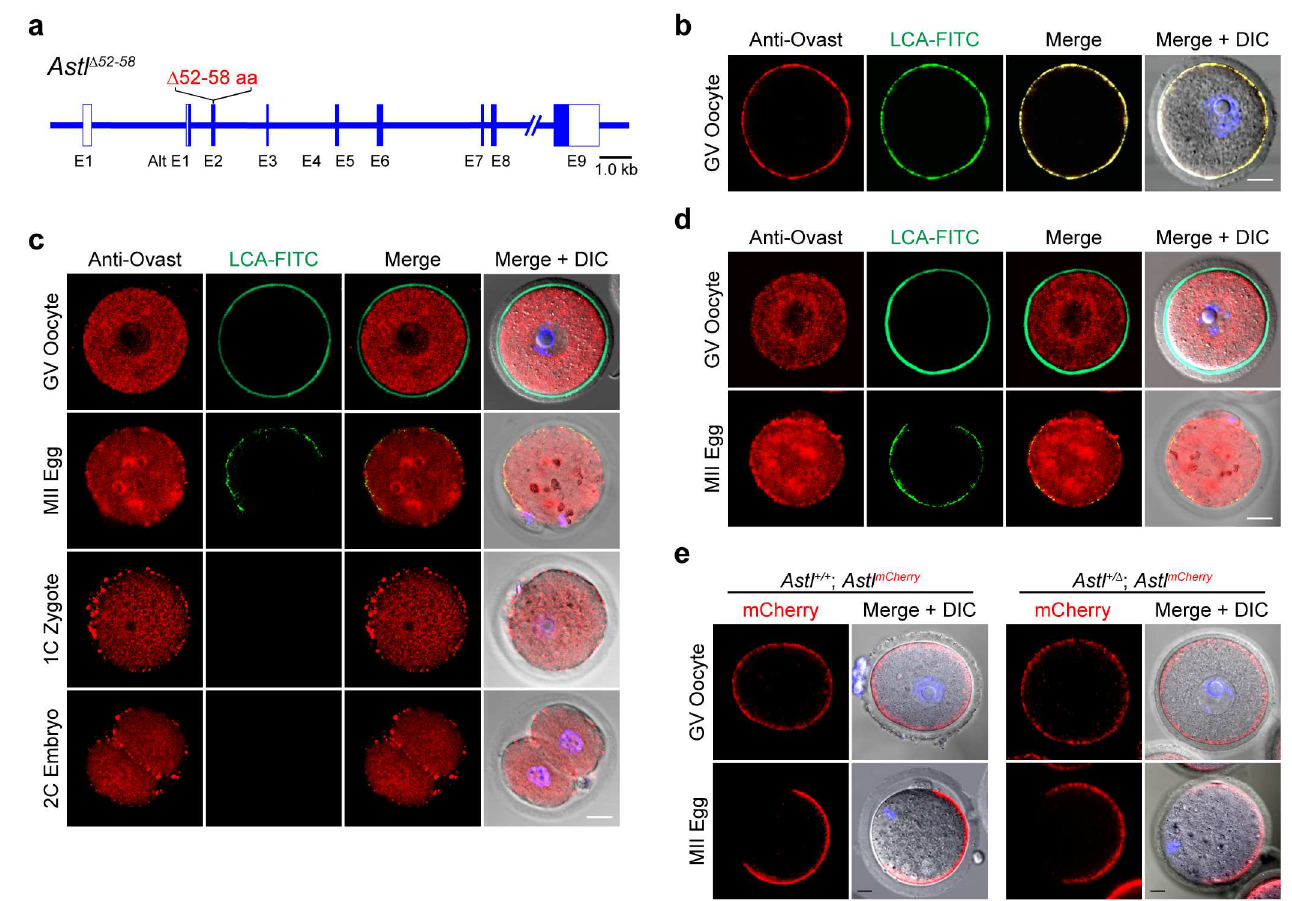
Fig 4. Ovastacinis not present in cortical granules after partial deletion of the localization motif. (a) Schematic representation of the CRISPR/Cas9deletion mutation in Astl exon 2 that encodesovastacin Δ 52–58 . (b) Wild-type GV-intact oocytes were fixed, permeabilizedand stained with antibodiesto ovastacin, LCA-FITC and imaged by confocaland DIC microscopy. (c) Same as (b) with GV-intact oocytes, ovulated MII eggs, 1-cell zygotes and 2-cell embryos from Astl Δ / Δ mice. (d) Same as (b) with GV-intact oocytes and ovulatedMII eggs from Astl +/ Δ mice. (e) GV- intact oocytes and ovulated MII eggs from Astl +/+ ; Astl mCherry and Astl +/ Δ ; Astl mCherry mice were fixed, permeabilizedand imagedby confocaland DIC microscopy. Scale bars, 20 μ